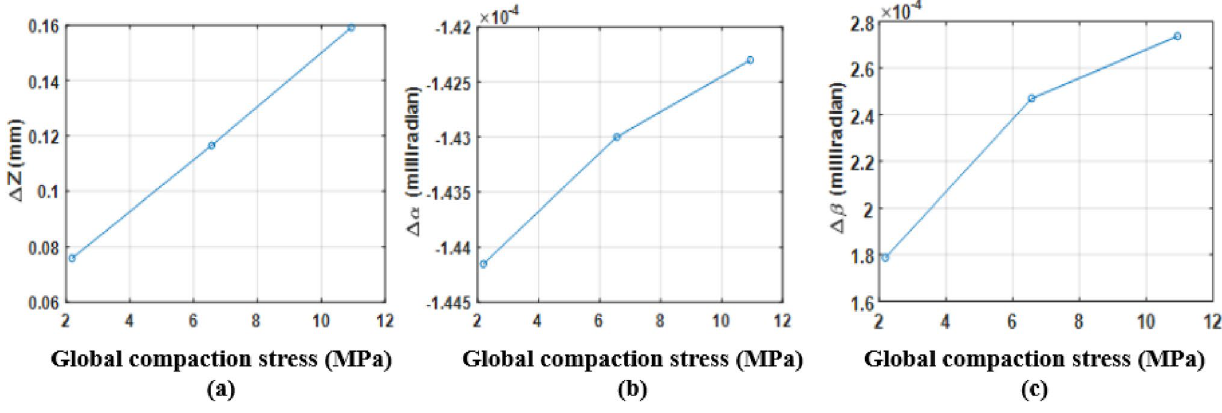
Figure 13. Evolution of Δ torsor components; ( a ) Δz; ( b ) Δα; ( c )